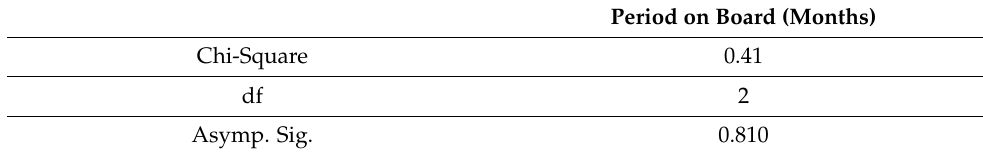
Table 15. Kruskal–Wallis test results for rank.